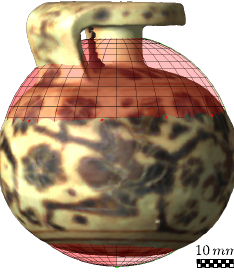
Figure 7: An aryballos , UMJ Inv.-No. 8738 (Karl et al., 2009), a vessel with a spherical shape that is well-suited for the equirect- angular projection. Note that the sphere does not envelop the object. This signifies that the object is not perfectly spherical.